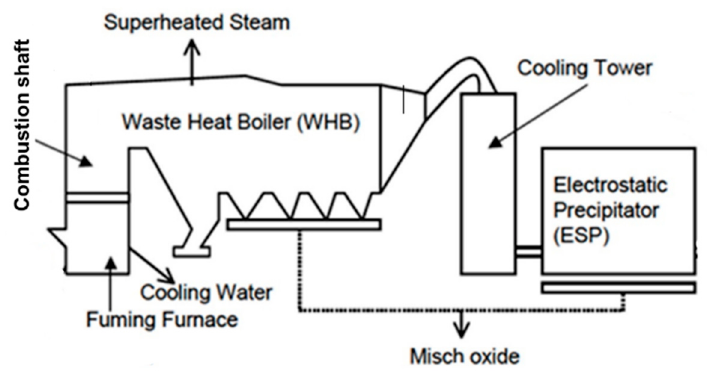
Figure 4. Schematic of the zinc fuming process in the Boliden Rönnskär smelter [20].